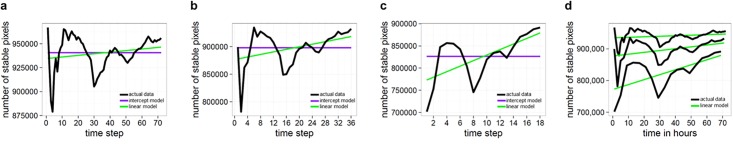
The development of stability over time.The black lines represent the number of stable pixels between two time slices, plotted for three different resolutions. Purple and green lines show intercept-only and linear models fitted to the data, respectively. (a) Number of stable pixels over time for 1-hour-intervals. (b) Number of stable pixels over time for 2-hour-intervals. (c) Number of stable pixels over time for 4-hour-intervals. (d) All three levels of granularity in one figure. There is a positive slope in the linear models for each, but the slope is steeper at coarser time intervals (as indicated by the lower numbers of stable pixels, more change can occur in these within a single time step).